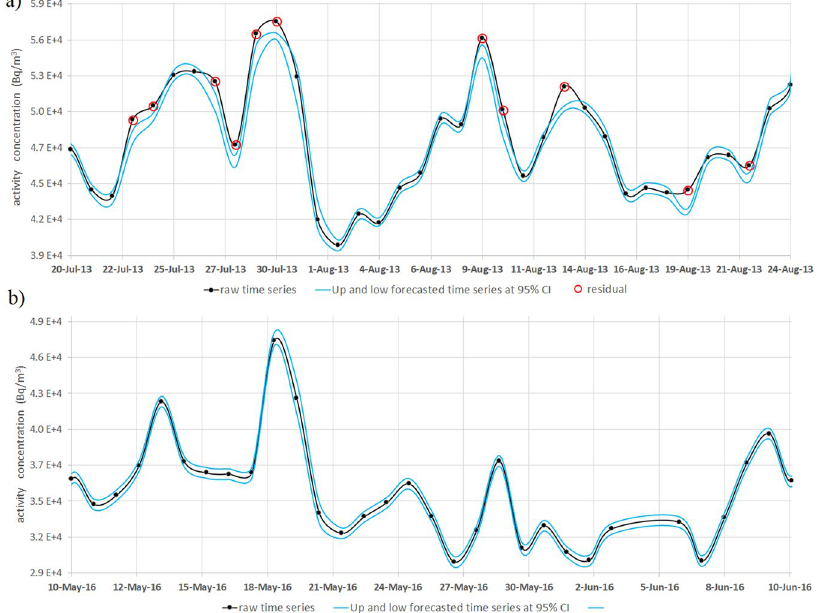
Figure 6. Example of residuals detection criterion applied two parts of the radon time series at OLB site. The graphs show the raw signal of the 222 Rn activity concentration at Monte Olibano (in black) site during the period 20 July 2013–24 August 2013 ( a ) and the period 10 May-10 June 2016 ( b ), delimited by two signals (in cyan) obtained by the forecasted time series, from MLR + EMD + SVR method, at 95% CI. The data that are beyond those two levels, present only in the graph ( a ), are denoted as residuals (red circles). Hence, the residuals values are obtained as difference between the raw signal amplitude and one of two levels (lower or